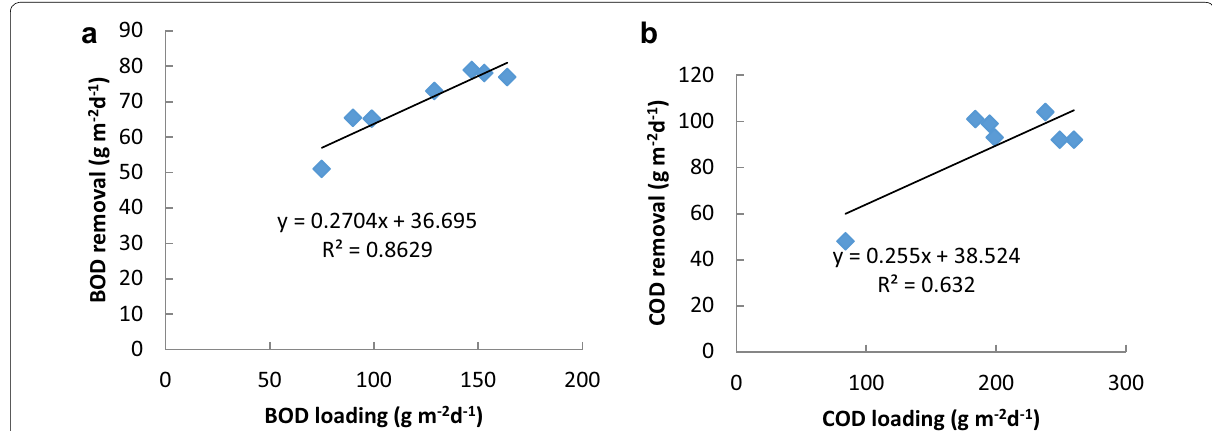
Fig. 1 Removal of nutrients during system operation: a BOD 5 mass loading vs. mass removal and b COD mass loading vs. mass